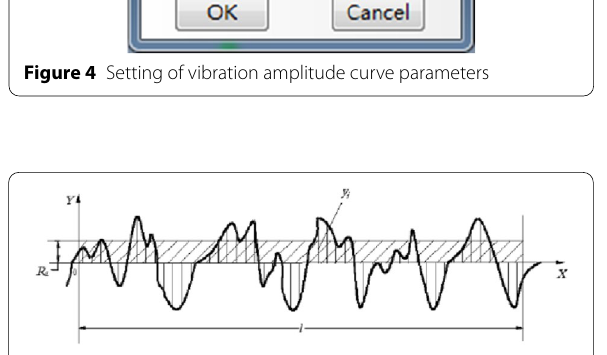
Figure 5 Diagram of arithmetic average deviation [23]